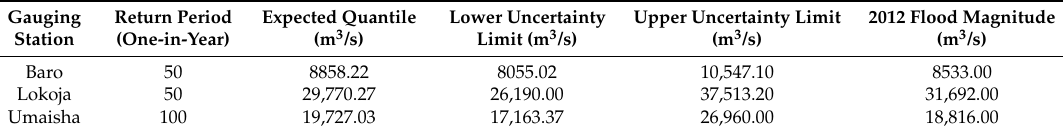
Table 13. Assessment of flood return period of the 2012 flood event in